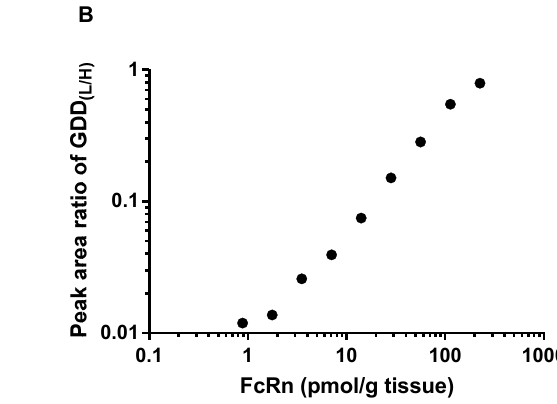
Figure 1. FcRn measurement in human tissues. ( A ) Correlation of peak area ratio from measured FcRn peptide (Light, L) to SIL internal standard (Heavy, H) of human tissue samples between quantification (GDD) and confirmatory (NGL) peptides, with a high Pearson r score of 0.95. ( B ) Quantification range of hFcRn in tissue was 0.89–226.35 pmol / g tissue using the peak area ratio of the GDD peptide. Shown is the average of a duplicate calibration curve.